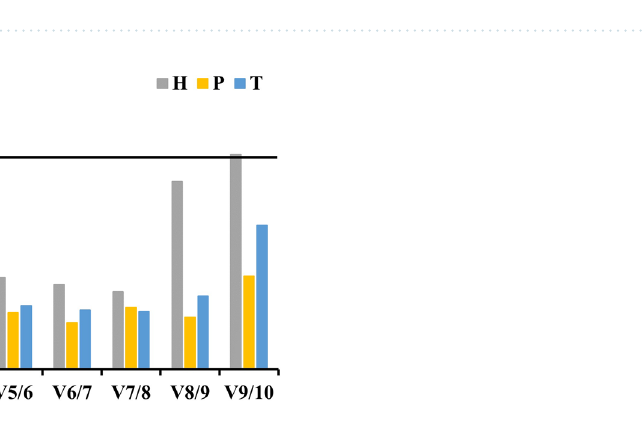
Figure 5. Determination of the optimal number of reference genes. H hypothalamus, P pituitary, T testis.